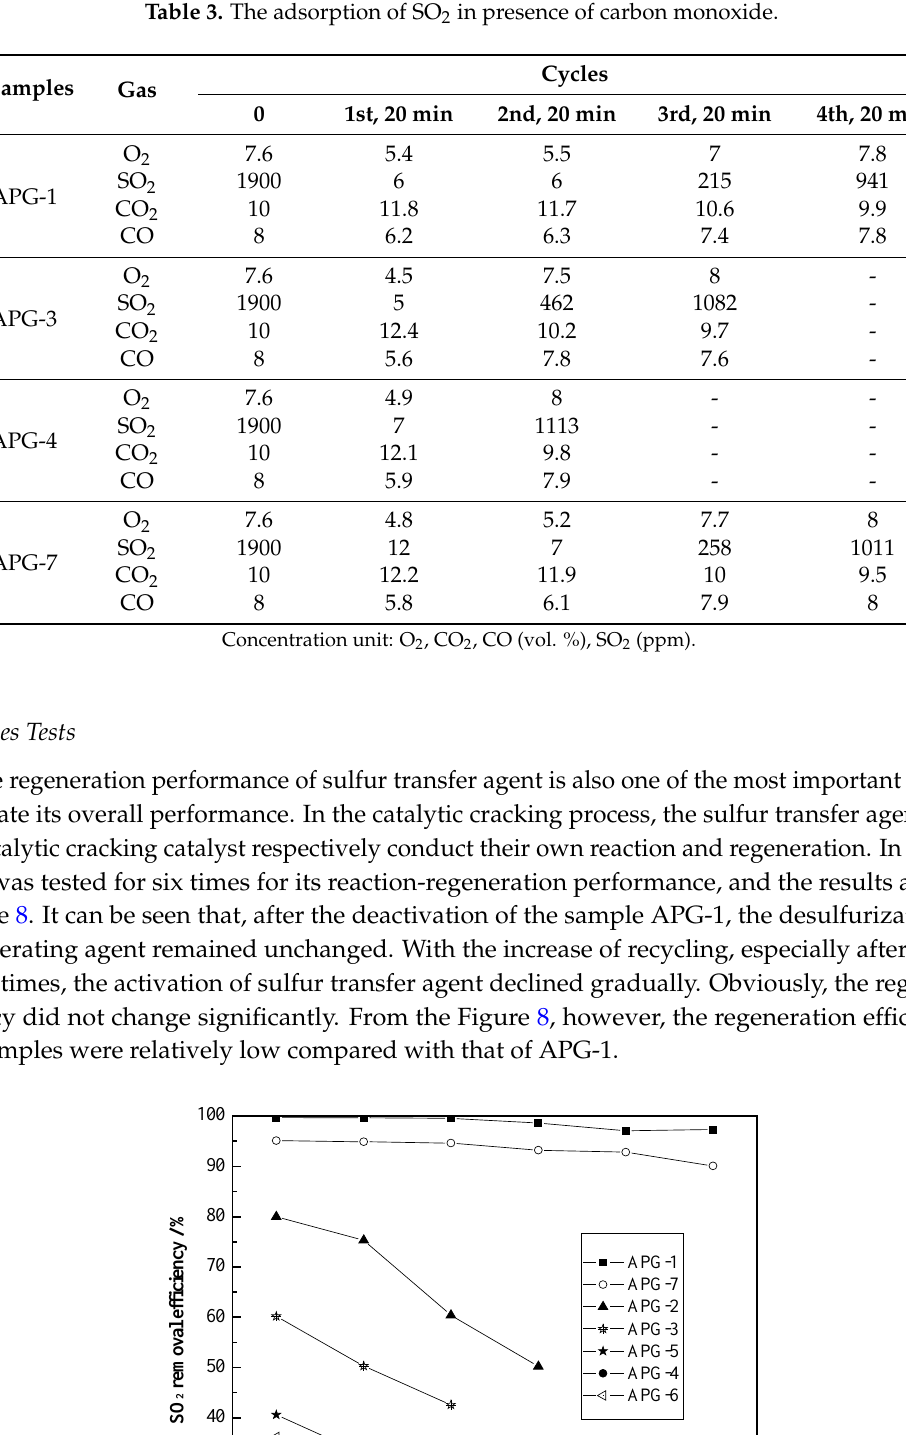
Table 3. The adsorption of SO 2 in presence of carbon monoxide.